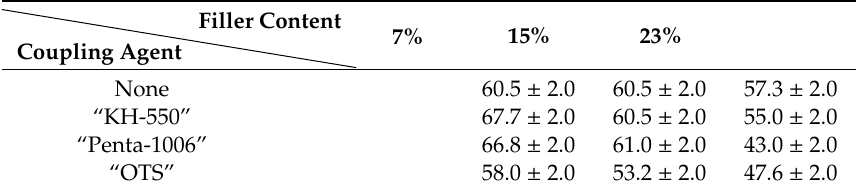
Table 6. Temperature ( ◦ C) of the UHMWPE-based composites loaded with wollastonite under the “severe” conditions of tribological loading: the “pin-on-disk”